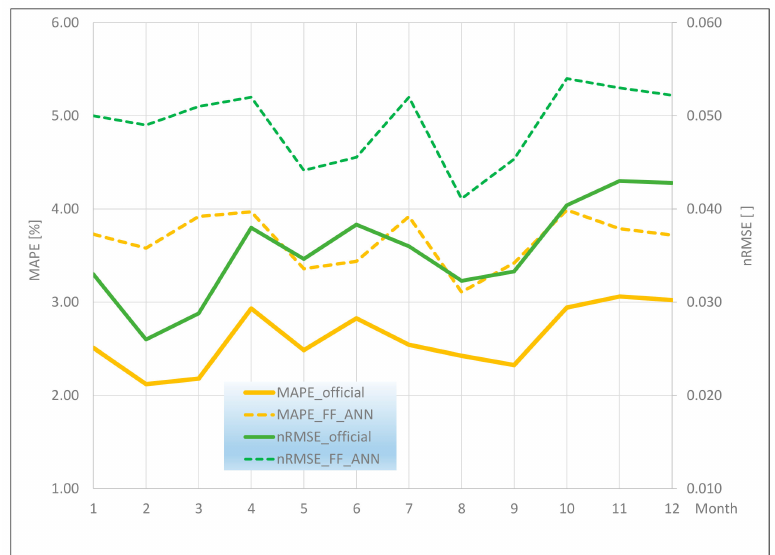
Figure 13. Comparison of the variation of monthly MAPE and nRMSE for the official forecasts and the FF ANN forecast during